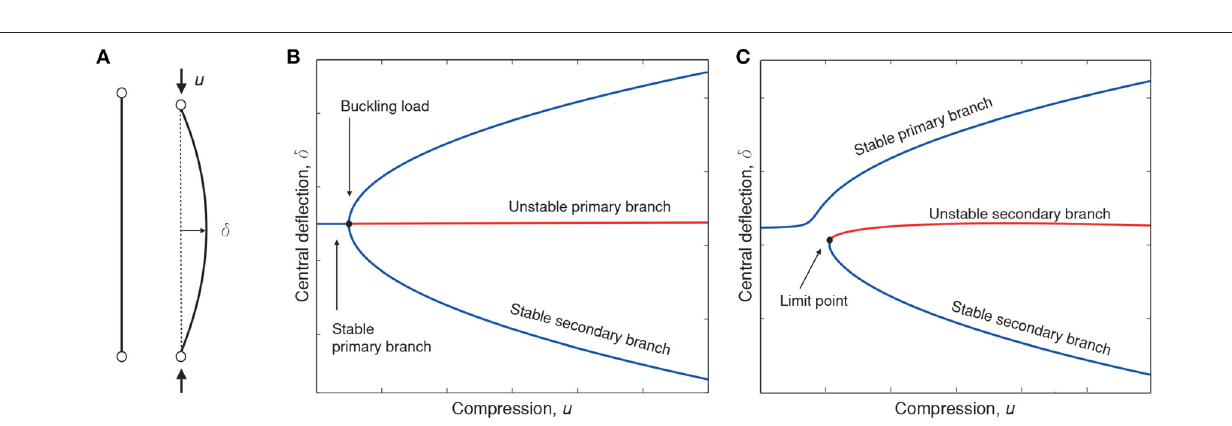
FIGURE 18 | Buckling of a simply-supported strut and corresponding equilibrium diagrams. (A) The strut deflects sideways when subjected to a compressive force greater than the buckling load. (B) An idealized symmetric strut with no geometric or loading imperfections features a symmetric pitchfork bifurcation diagram in load vs. displacement space. (C) Initial imperfections break the